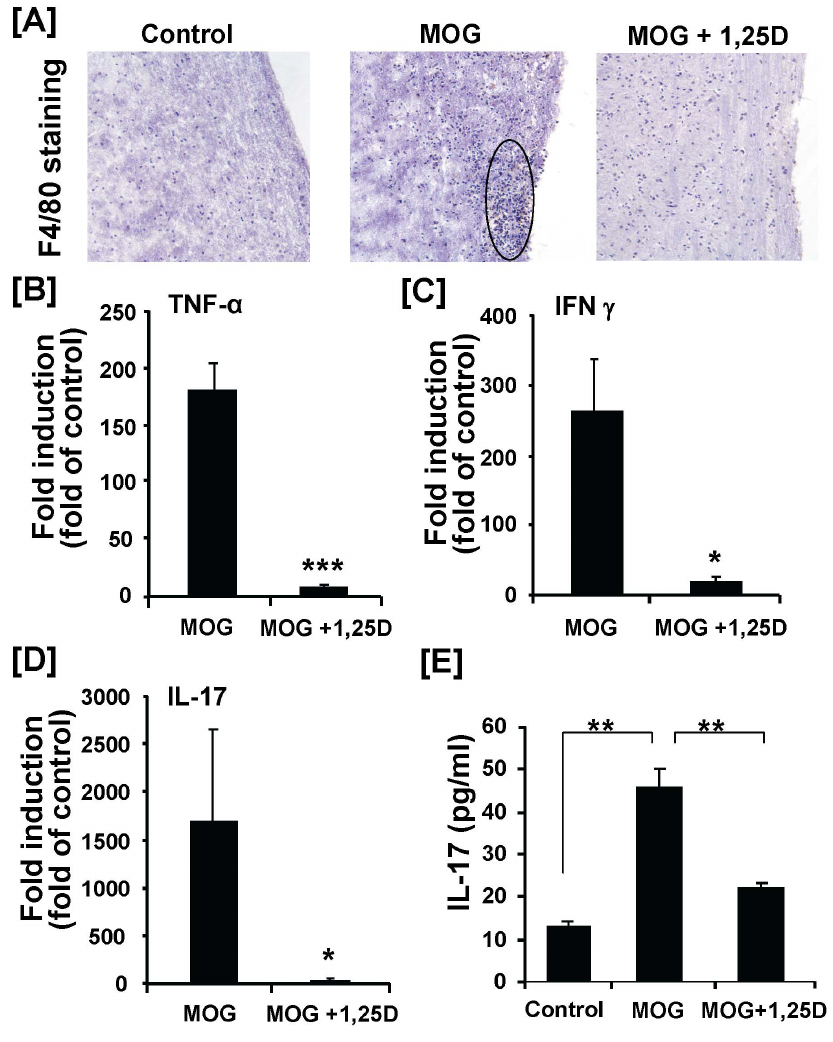
Figure 2. Suppressive effect of 1,25(OH) 2 D 3 on inflammatory cell infiltration and inflammatory cytokine production in MOG- induced EAE. Animal treatments were described in Figure 1 legend. Fourteen days after MOG injection, spinal cords were collected for RNA isolation and immunohistochemical analysis. ( A ) Representative F4/80 immunostaining of frozen spinal cord sections. Spinal cords from MOG treated mice showed dense mononuclear cell infiltration (circle). The number of F4/80-positive cells were reduced following treatment of EAE mice with 1,25(OH) 2 D 3 . Three mice were analyzed in each group. Original magnification was X10. ( B–D ) Real-time RT-PCR analysis of the inflammatory gene expression (TNF- a , INF- c and IL-17) in spinal cord. ( E ) Serum concentration of IL-17 was determined by ELISA. Data represent the means 6 SEM (n=4) from one of two independent experiments. * P , 0.05; ** P , 0.01; *** P , 0.001.